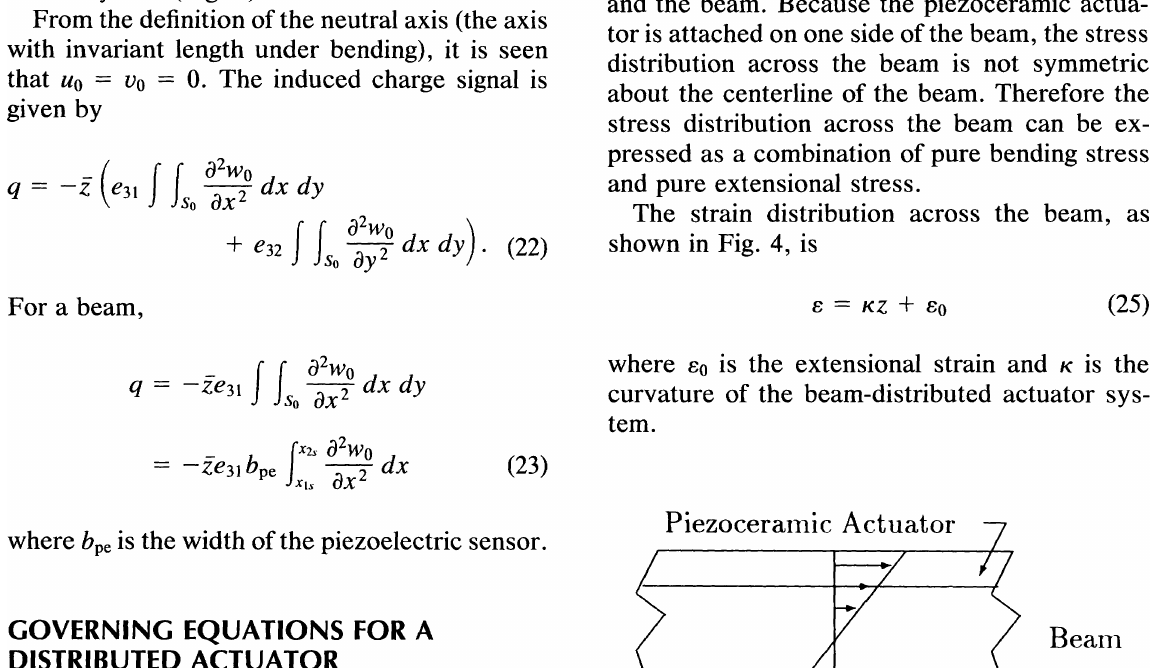
FIGURE 4 Strain distribution in beam-distributed actuator